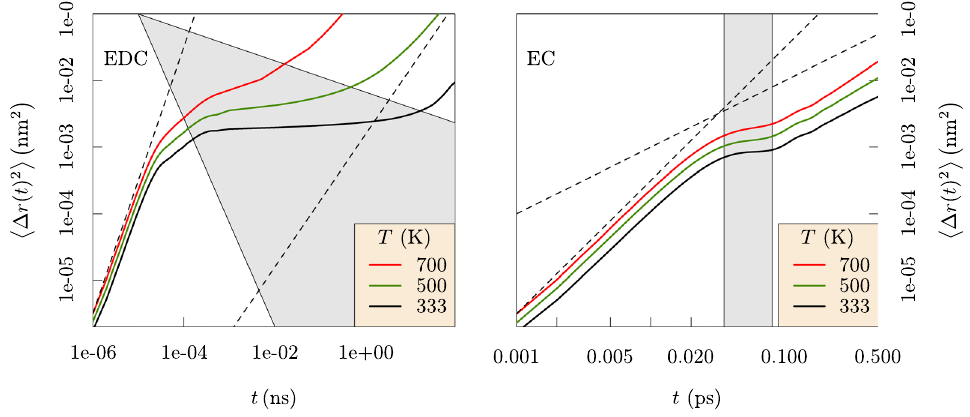
Figure 3. Mean-squared displacements, ∆ r t ( ) 2 , measured for Li + in EDC (left) and EC (right). The behavior in EDC at intermediate timescales 0.001 < t < 1 (ns) demonstrates trapping of the Li + ion. Ballistic motion r t t ( ( ) ) 2 2 ∆ ∝ is evident at short timescales, while diffusive motion ∆ ∝ r t t ( ( ) ) 2 1 appears at long timescales in both EDC and EC solvents. Dashed lines with slope 1 and 2 (log-scale) are provided as visual cues. At high T , the trapping regime (shaded region) diminishes and the EDC matrix behaves more like liquid EC. Note that the time scales differ dramatically between the two systems. (Redrawn with permission from ECS Transactions 77, 1155–1162 (2017)) 13